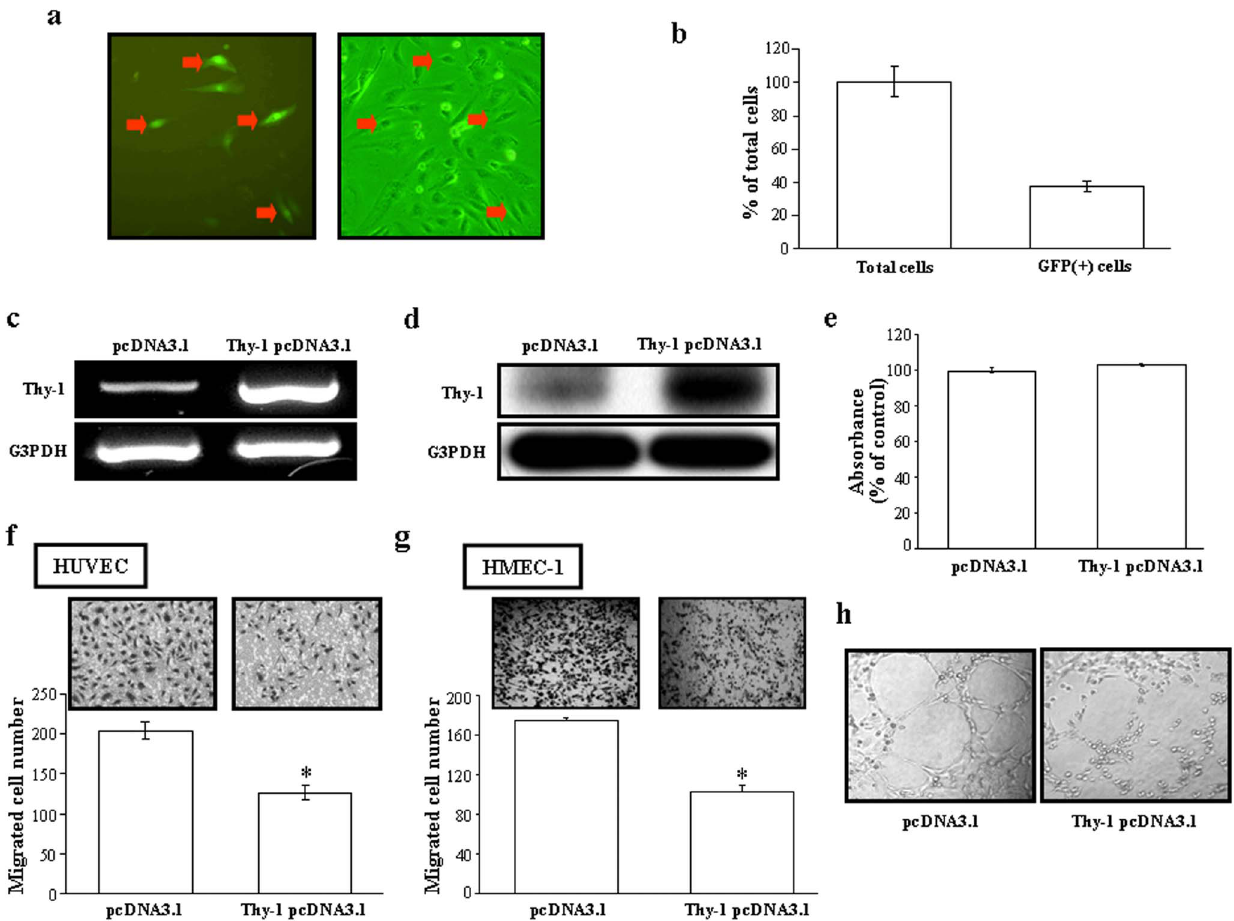
Figure 1. Effects of Thy-1 over-expression on proliferation, migration and capillary-like tube formation in vascular endothelial cells. (a) Representative micrographs of EGFP-positive cells in bright-field image (right panel) and immunofluorescence (left panel) are indicated by the arrows. (b) Quantitative results of the HUVEC expressing Thy-1-pCMS-EGFP-C1 (n=3). The transfection efficiency of Thy-1-positive cells is around 40%. Transfection of the HUVEC with Thy-1-pcDNA3.1 caused an increase of the levels of Thy-1 mRNA (c) and protein (d) as detected by RT-PCR and Western blot analyses, respectively. For Western blot analysis, membrane was probed with anti-G3PDH antibody to verify equivalent sample loading. RT-PCR products of G3PDH were used as an internal control for RT-PCR analyses. (e) Over-expression of Thy-1 did not affect the proliferation of HUVEC. The cells were transfected with pcDNA301 (control) or Thy-1 pcDNA3.1 for 96 h and then harvested for MTT assay. Values represent the means 6 s.e.mean. (n=5). Over-expression of Thy-1 inhibited the migration of HUVEC (f) and HMEC-1 (g). Top panel: a representative result of the migrated HUVEC transfected with pcDNA301 or Thy-1 pcDNA3.1. Bottom panel: quantification of migration inhibition. The quantified results were expressed by percentage of control. Values represent the means 6 s.e.mean. (n=3). (h) Over-expression of Thy-1 inhibited the capillary-like tube formation.